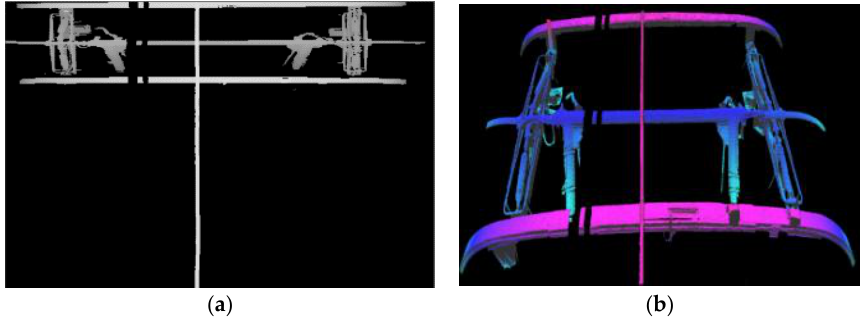
Figure 11. ( a ) Experiment 2D Data; ( b ) Experiment 3D Data.